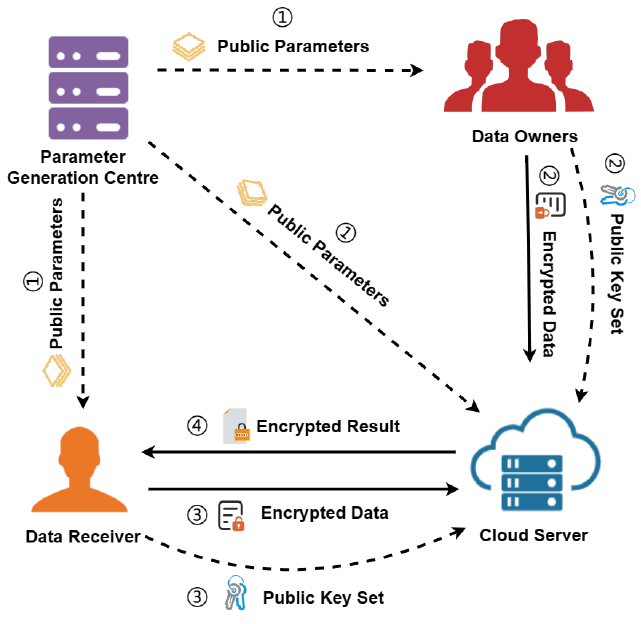
Figure 3. System